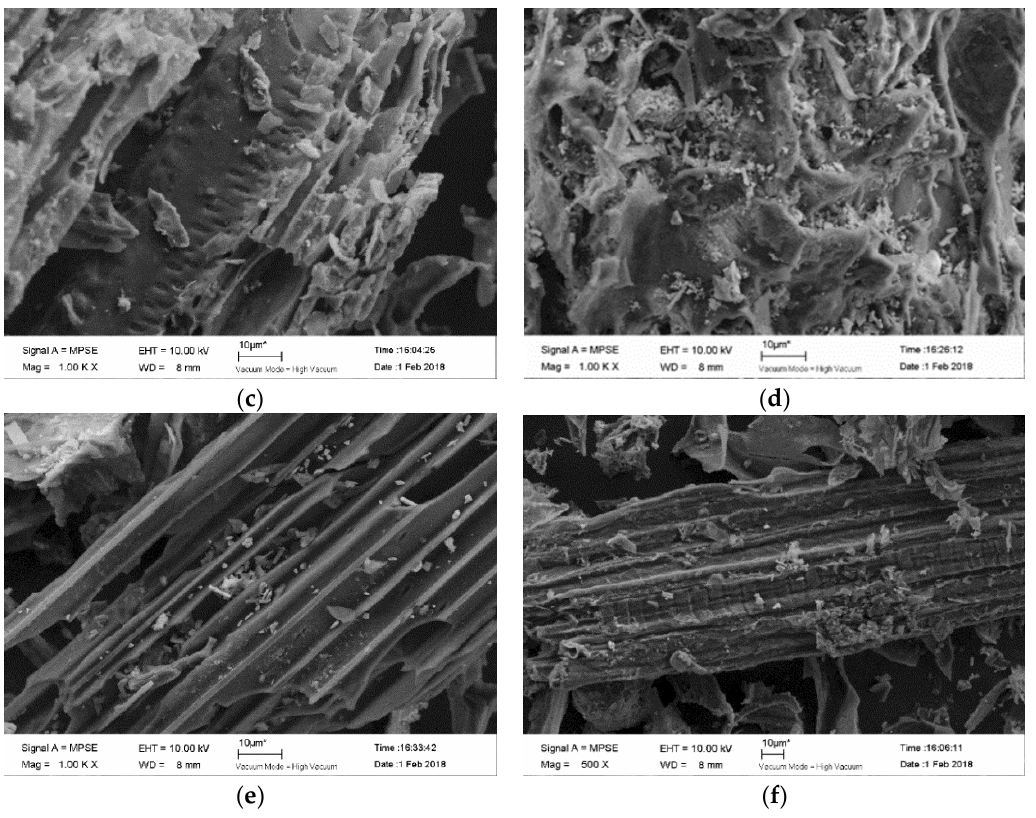
Figure 1. SEM analysis of the absorbents: ( a ) FMCBC 1 ; ( b ) FMCBC 1 -As(III); ( c ) FMCBC 2 ; ( d ) FMCBC 2 - As(III); ( e ) FMCBC 3 ; ( f ) FMCBC 3 -As(III).